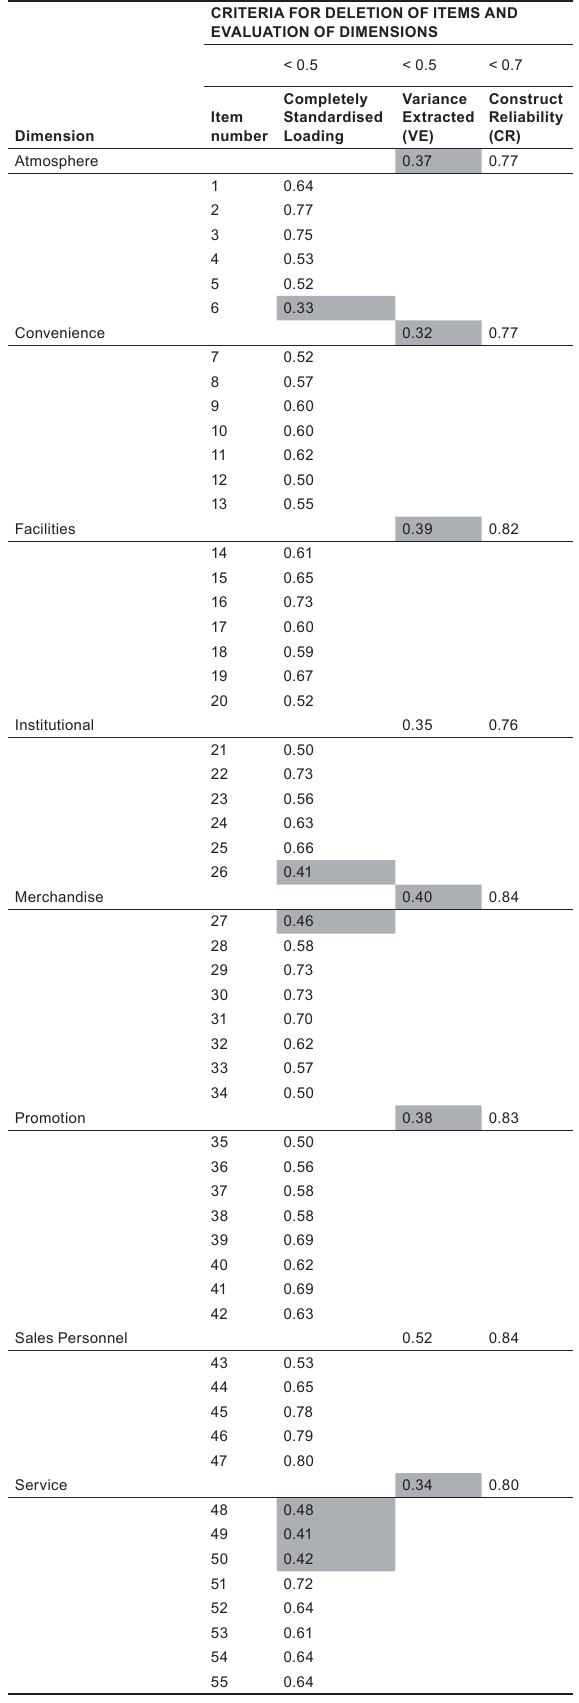
TABLE 4 Summary: Completely standardised loadings, VE and CR – Mall Intercept